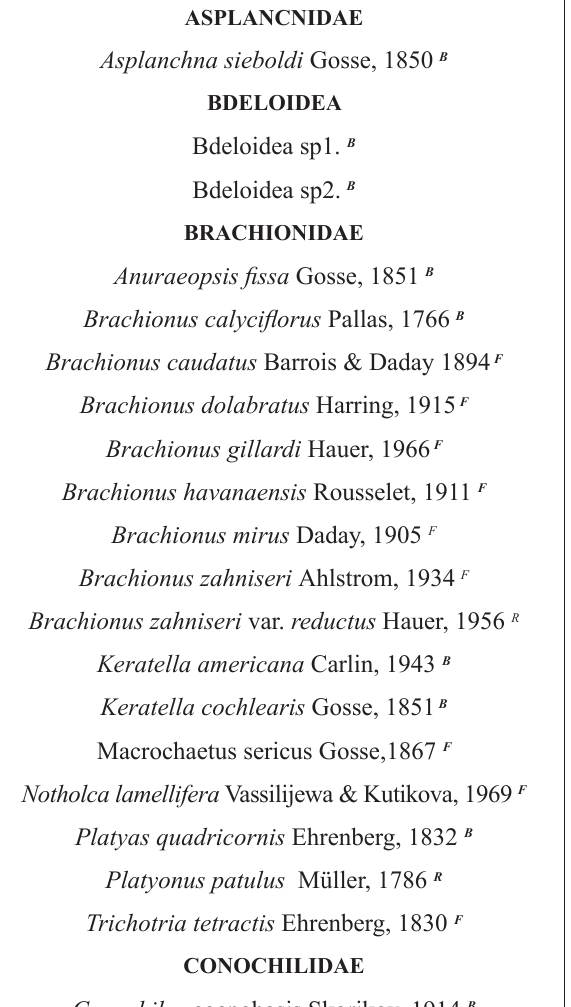
Taxonomic inventory of rotifers in LARR and species occurrence during two phases of the flood pulse (receding and flooding). Bold symbols summarizes occurrence in: B= both phases; R= receding; F=